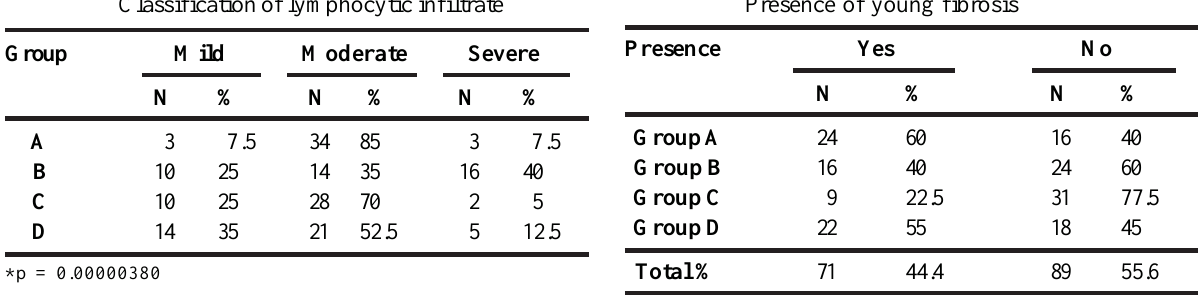
TABLE 3 - Histopathological evaluation of surgical wound. TABLE 4 - Histopathological evaluation of surgical wound.